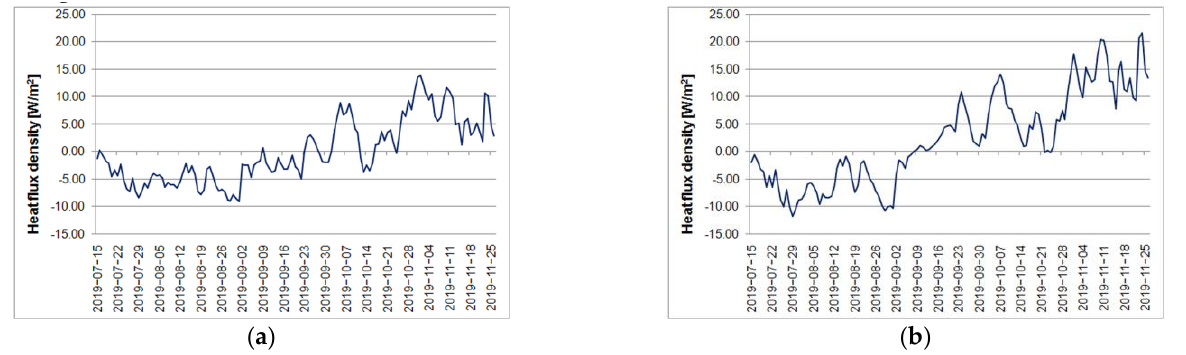
Figure 25. Calculated steady state heat flux density from the considered TABS: ( a ) upwards to the adjacent room; ( b ) down- wards to the space below the TABS.